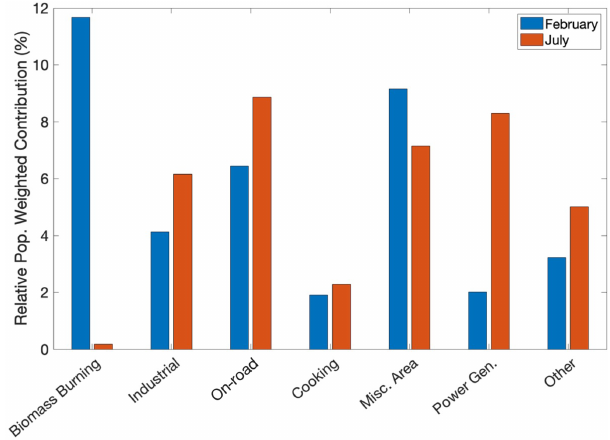
Figure 14. Relative contributions from local sources to population- weighted total PM 2 . 5 concentration for February and July